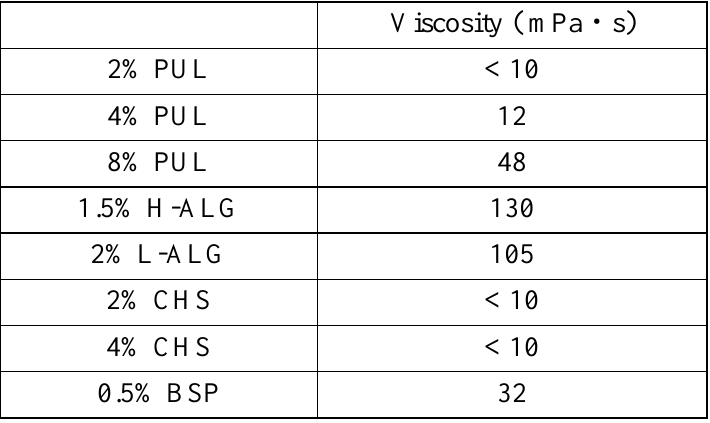
Table 1. Viscosities of polysaccharide solutions at 20 °C.